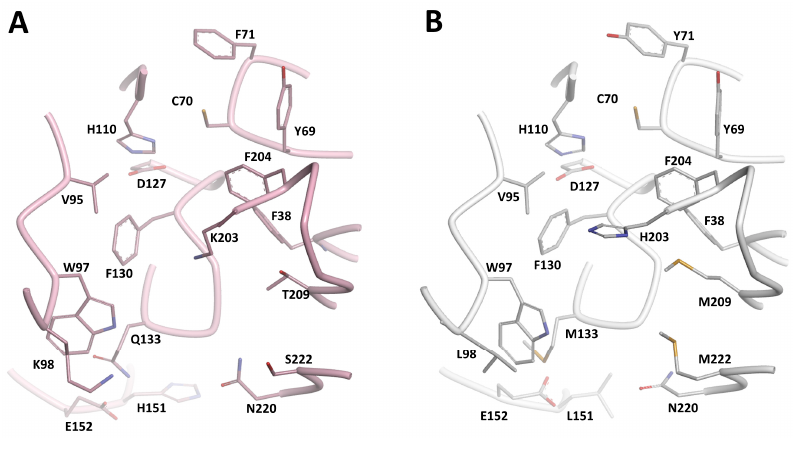
Figure 3. Comparison of the binding pockets of TBNAT and MMNAT. A ribbon representation shows the main residues in the binding pocket of ( A ) TBNAT and (PDB code 4BGF, 2.1 Å) and ( B ) MMNAT (PDB code 2VFB; 2.1